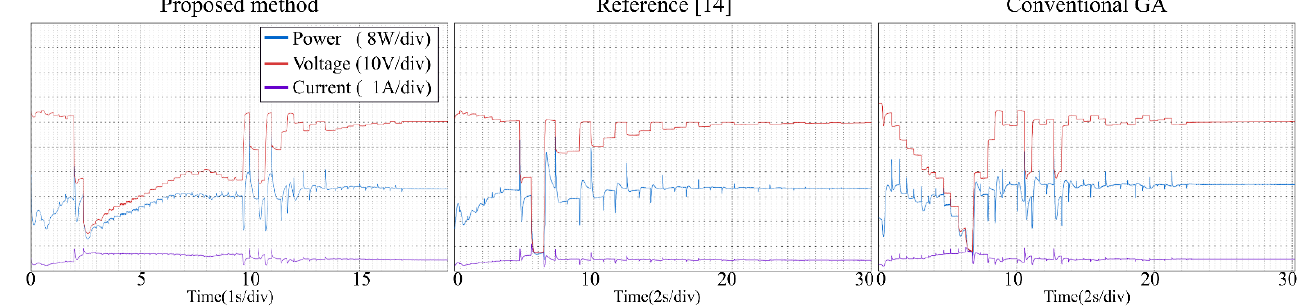
Figure 17. Tracking process—Pattern 5.